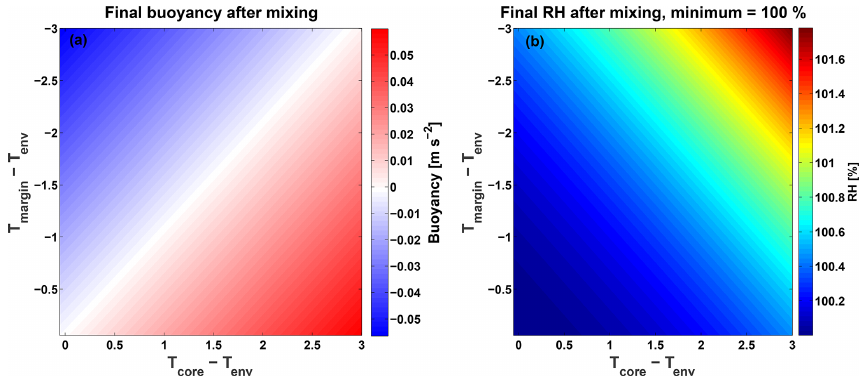
Figure B1. Phase space presenting the resultant buoyancy (a) and relative humidity (RH; b ) when mixing B core and B margin parcels with equal RH but different temperatures. A mixing fraction of 0.5 is chosen. Both parcels are initially saturated (RH = 100%) and have an LWC of 0.5gkg − 1 . The environment has a temperature of 15 ◦ C and pressure of 850mbar. The x(y) axis spans the range of temperature differences between the B core ( B margin ) parcel and the